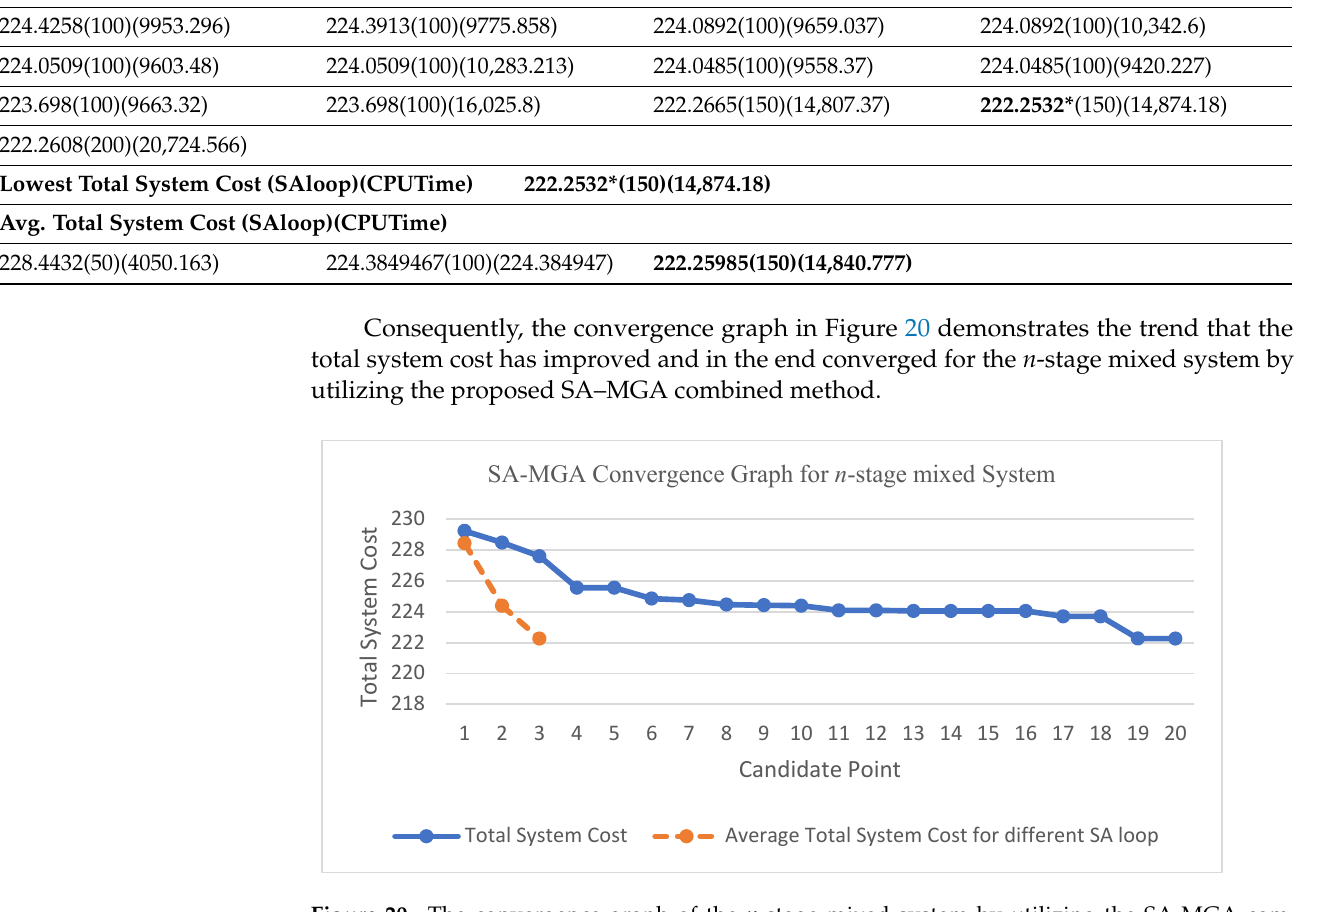
Table 40. Optimal Solutions obtained by SA–MGA for the for the n -stage mixed system. SAloop =150 cr-rate = 0.95 mu-rate = 0.5 GApopulation = 200 GAloop = 200